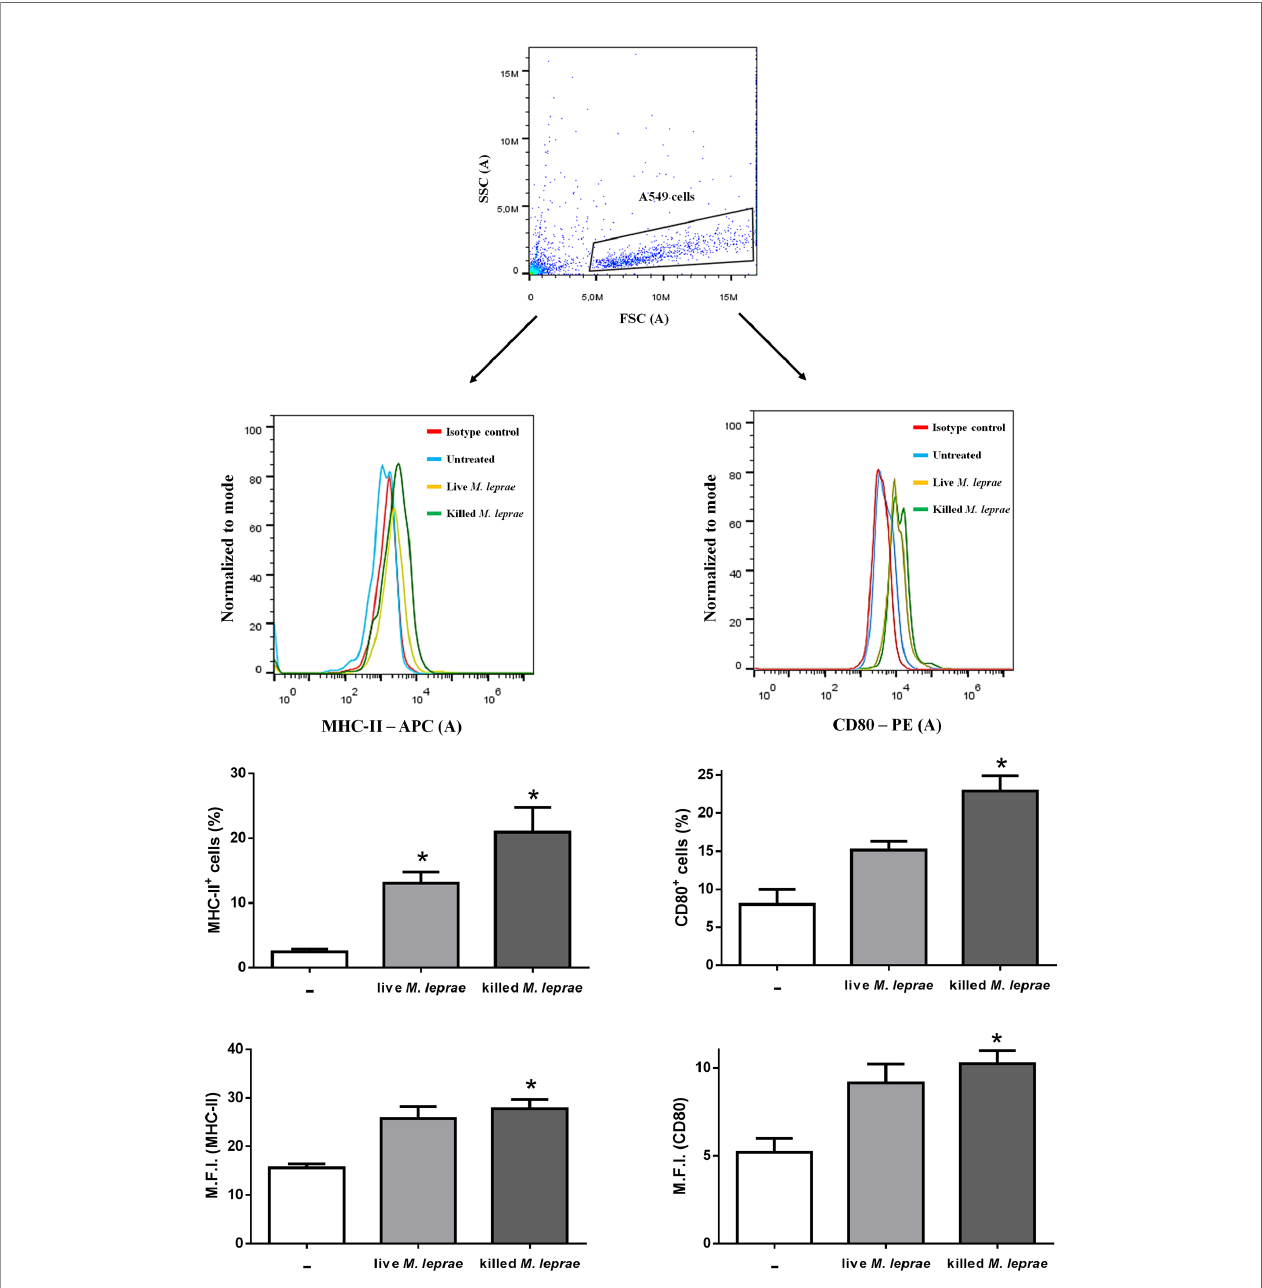
FIGURE 2 | Human alveolar epithelial cells express MHC-II and CD80 in response to M. leprae . Flow cytometry measurement of MHC-II (left) and CD80 (right) expression on the surface of A549 cells stimulated with live or killed M. leprae at a bacterium:cell ratio of 50 for 48 hours. Top panel shows the gating strategy to select the A549 cells population. The representative histogram plot together with the marker ’ s levels of positive cells and median fl uorescence intensity (M.F.I.) are shown by immuno fl uorescent labeling using anti-MHC-II and anti-CD80 antibodies conjugated to APC and PE, respectively. Unpaired t -test with differences considered statistically signi fi cant in relation to the untreated cells. *p < 0.05. Results shown as representative of 3 independent experiments performed in